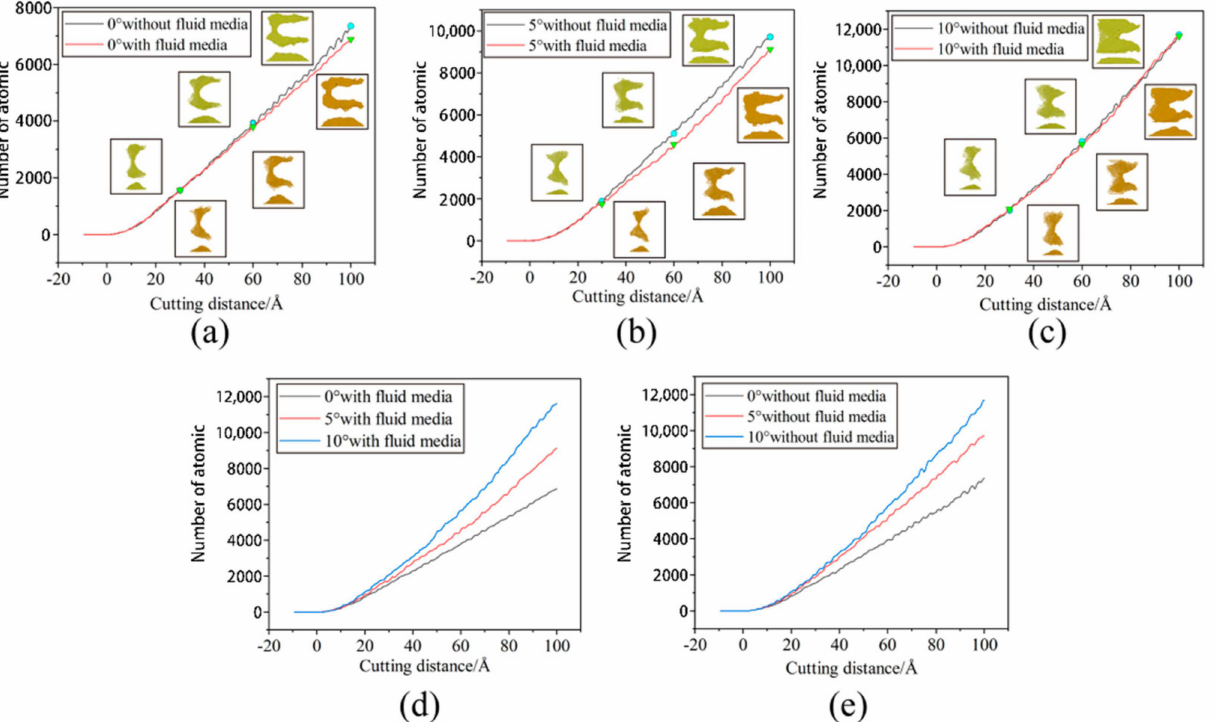
Figure 10. Number of atoms exceeding the workpiece surface. ( a ) θ = 0 ◦ ; ( b ) θ = 5 ◦ ; ( c ) θ = 10 ◦ ; ( d ) wet cutting; and ( e ) dry